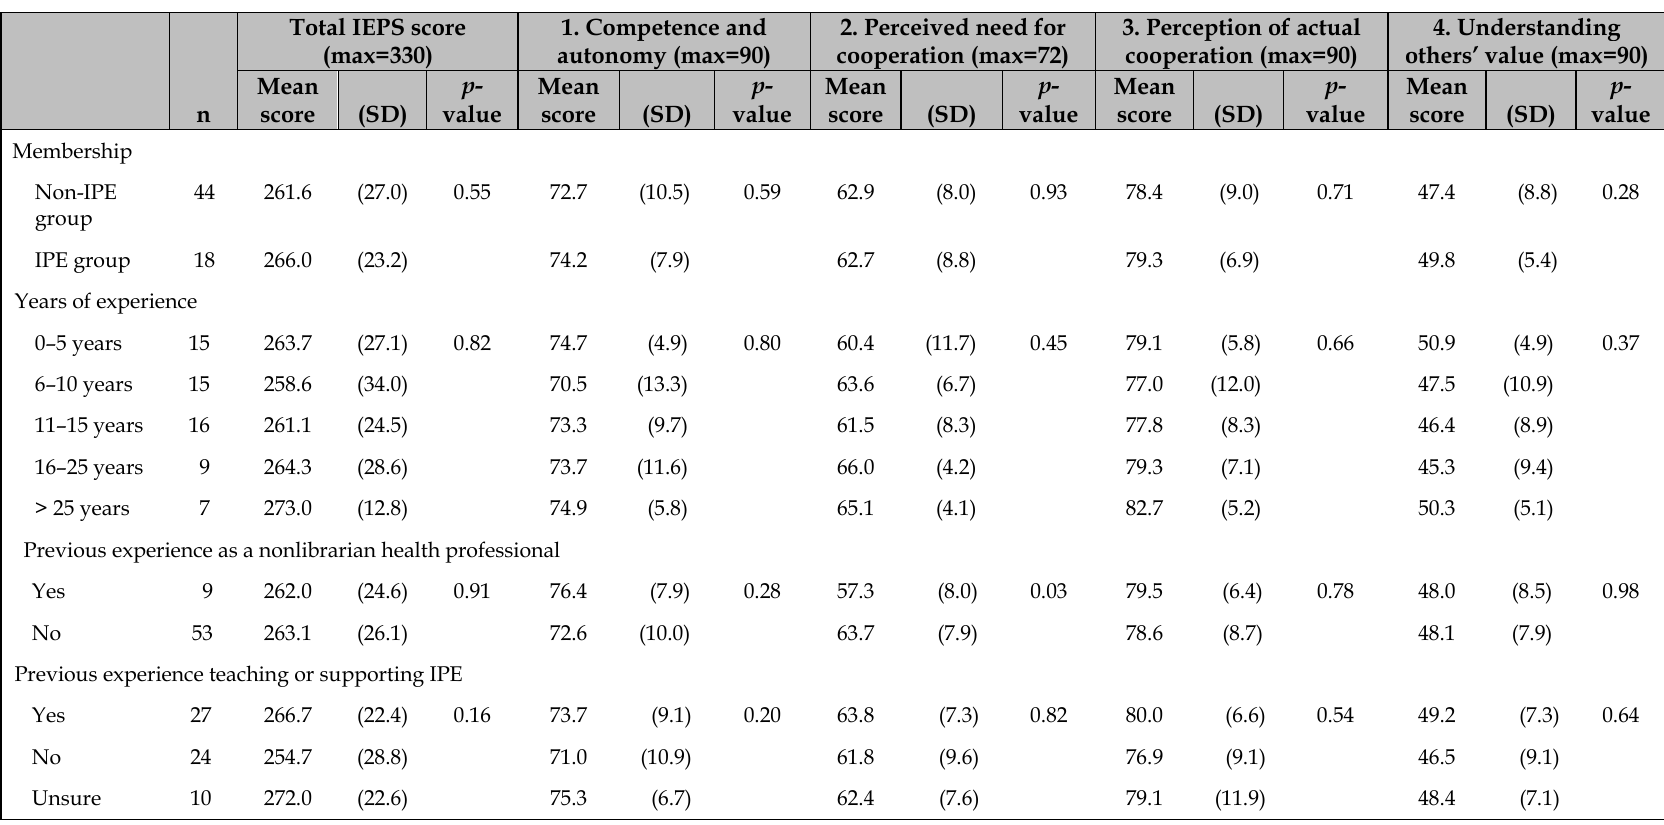
Table 2 Interdisciplinary Education Perception Scale (IEPS) mean scores and subscale